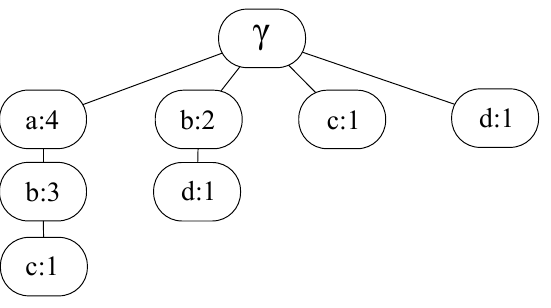
Figure 1. LZ tree after parsing the example movement history L = abababcdcbdab